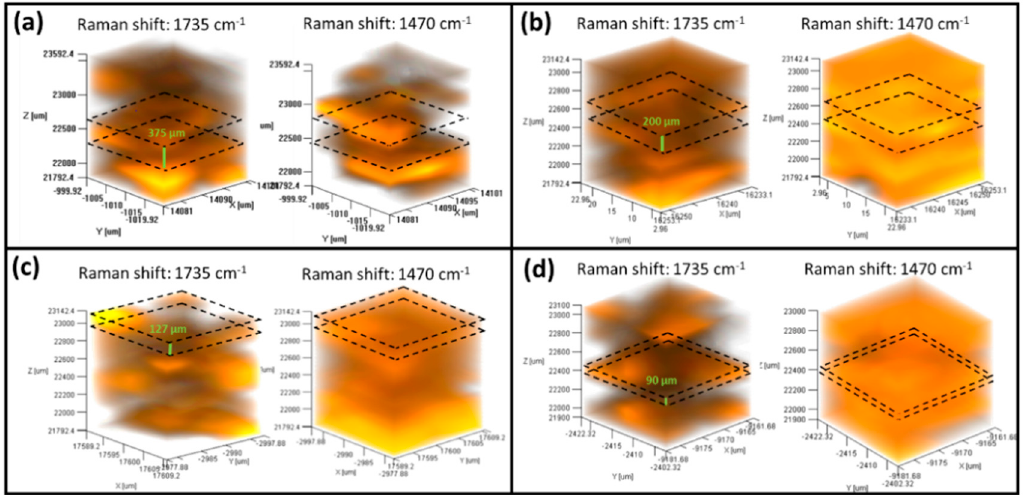
Figure 3. 3D Raman mapping images of the combined ion- and thermally crosslinked dual-polymeric hydrogels. All of these hydrogels comprise weights per volume concentration (% w / v ) of ( a ) 15 / 1.5, ( b ) 15 / 1.0, ( c ) 15 / 0.5, and ( d ) 15 / 0.25 (abundant alginate between boundaries).